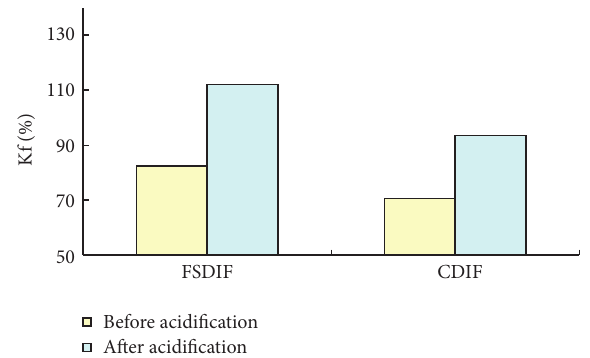
Figure 2: Performance comparison of the CDIF and FSDIF.